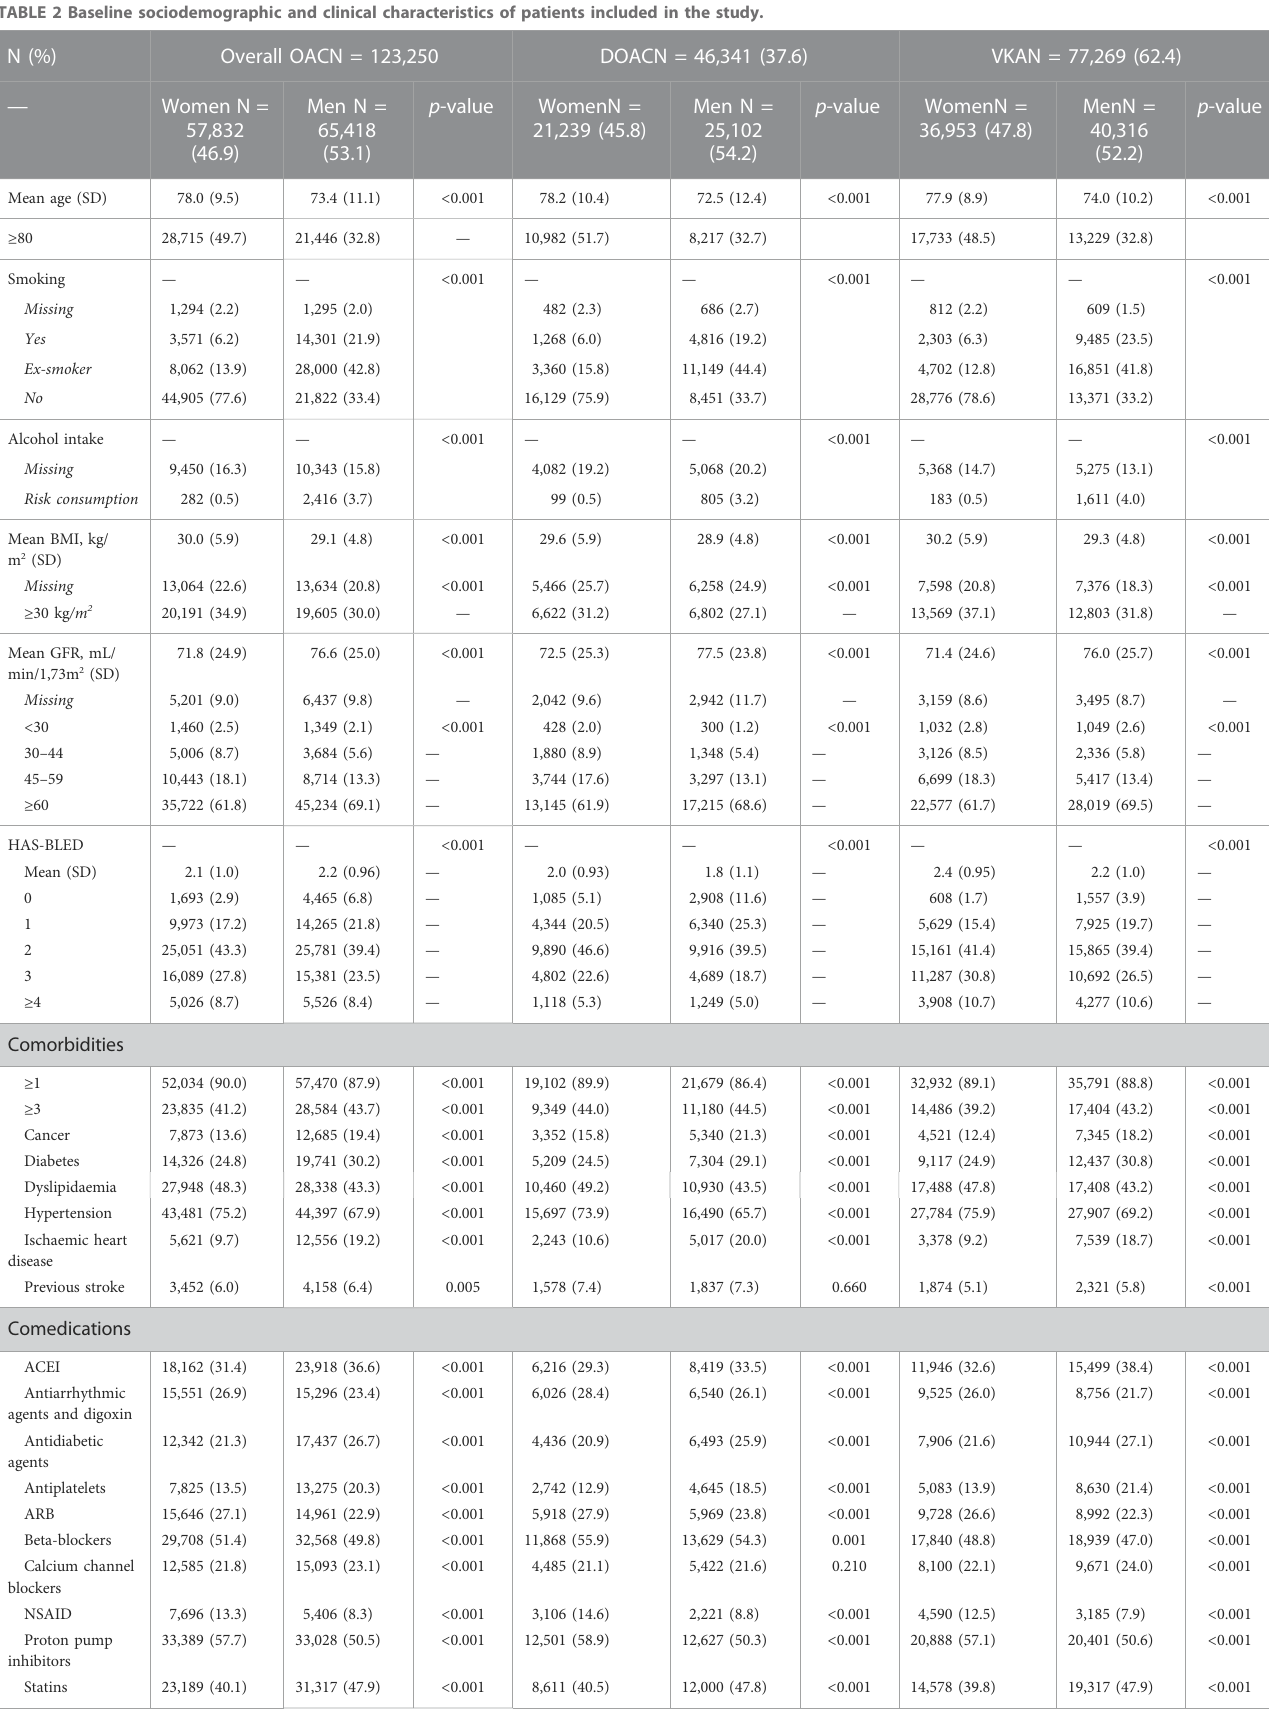
TABLE 2 Baseline sociodemographic and clinical characteristics of patients included in the